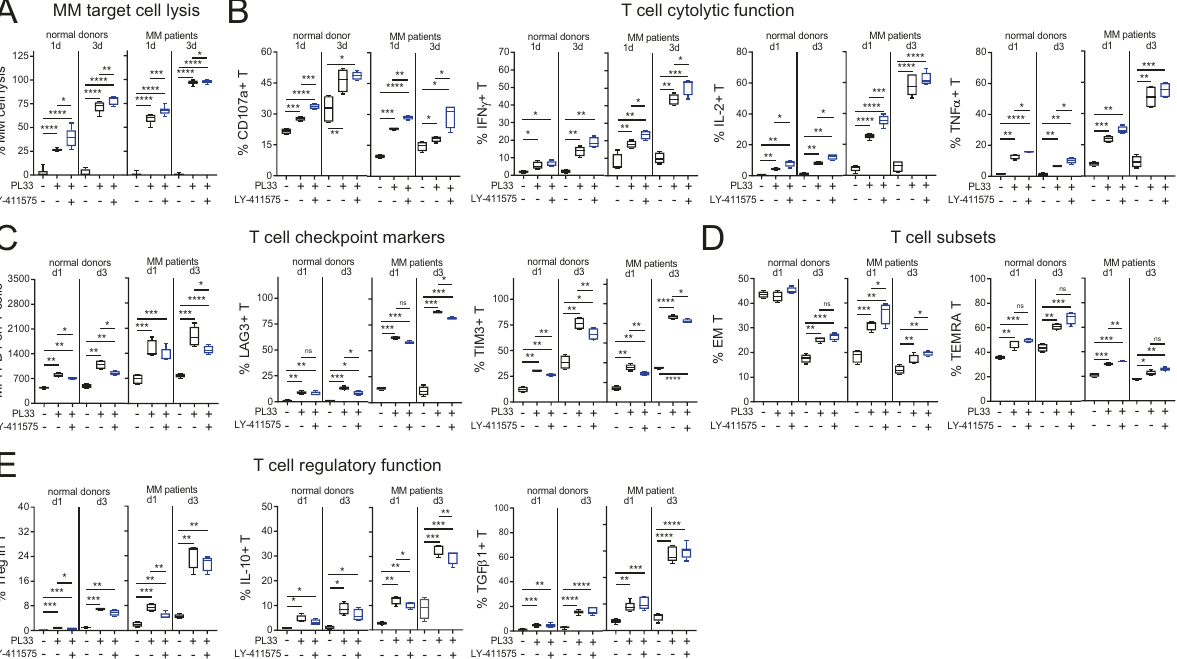
Fig. 5 LY-411575 co-treatment upregulated PL33-induced cytolytic markers without further increased expression of immune checkpoint molecules and regulatory cell subsets in T cells in 3 day-co-cultures. MM1S target cells were co-cultured with T cells from normal donors ( n = 5) or MM patients ( n = 5) (E:T = 1:1) for 1 and 3 days, in the presence ( + ) or absence ( − ) of 1 nM PL33 with or without 2 nM LY-411575. Shown are summary data (means ± SDs) for % CD138 + target cell lysis ( A ), 4 key markers for cytolytic function of T cells ( B ), 3 major checkpoint molecules on T cells ( C ), % differentiated T-cell subsets including effector memory (EM, CD45RA − CD62L − ) and terminal effector memory RA (TEMRA, CD45RA + CD62L − ) ( D ), as well as main molecules (IL-10, TGF β ) related to regulatory T (Treg, CD4 + CD25 + FoxP3 + ) cell function ( E ). Five independent experiments using T cells from normal donors (left) and MM patients (right) were done with each condition in triplicate. * P < 0.05; ** P < 0.01; *** P < 0.001; **** P < 0.0001; ns, not signi fi cant.